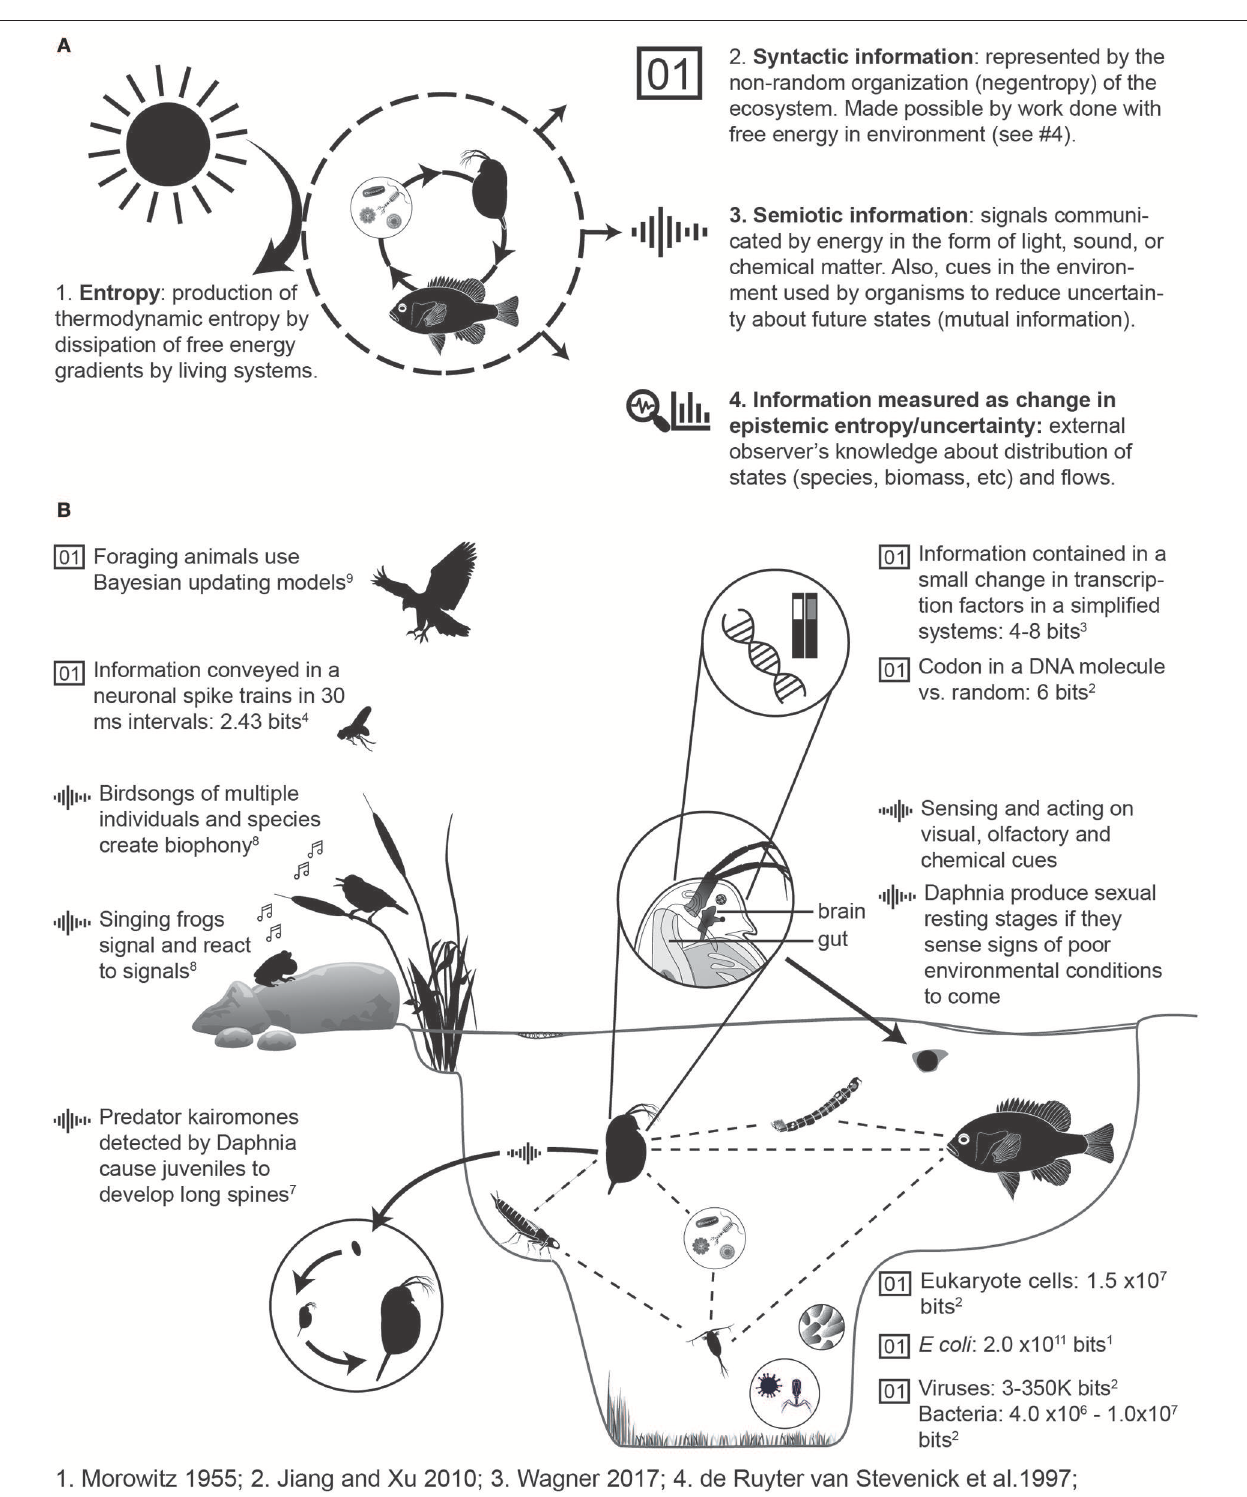
FIGURE 1 | Information takes a variety of forms in ecological systems. (A) In an ecological system such as a simple aquatic food chain (center circle), information is present as latent information, semiotic information, and information change as states change. This living system dissipates energy, and therefore has entropy. (B) In an